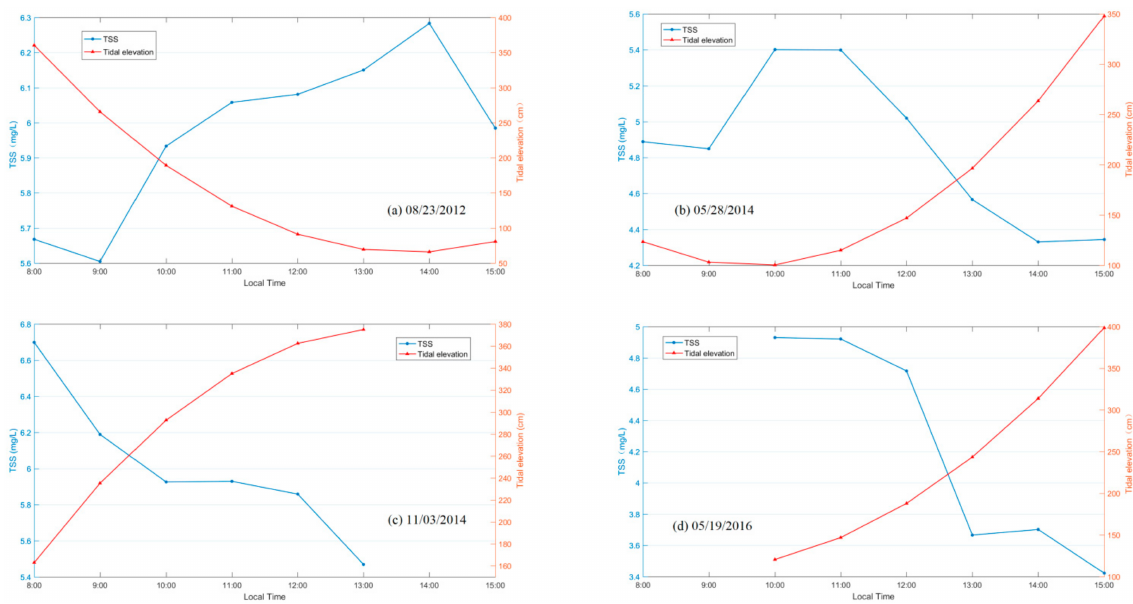
Figure 9. Relationship between variation of GOCI TSS and tidal elevation during 8:00–15:00 a day (the blue line is the variation of TSS, and the red line is the variation of tidal elevation; ( a ) is 23 August 2012; ( b ) is 28 May 2014; ( c ) is 3 November 2014; ( d ) is 19 May